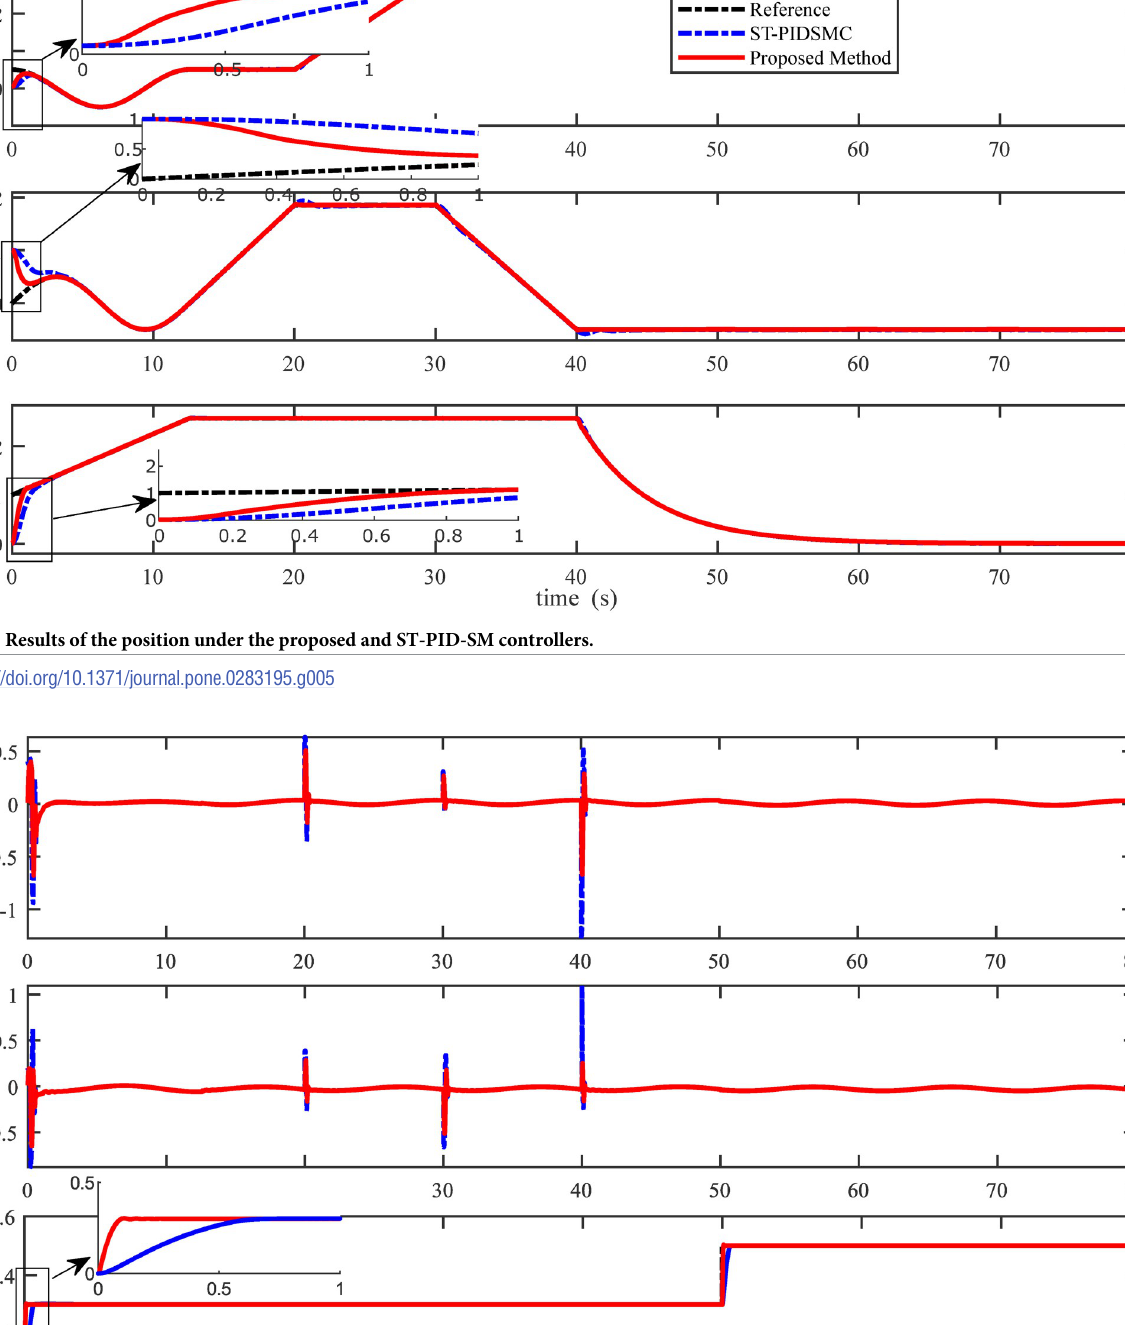
PLOS ONE | https://doi.org/10.1371/journal.pone.0283195 April 24,